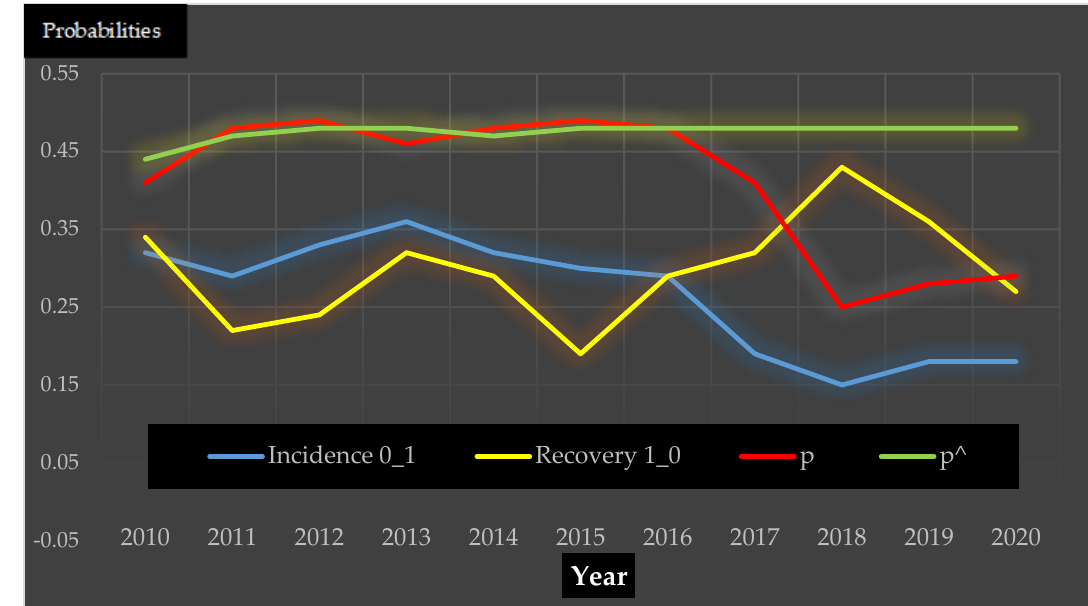
Figure 3. A comparative longitudinal line graph from 2009 to 2020 on four variables represented by the 4 coloured lines. 1. Red line - observed herd surveillance in pigs. 2. Green line - discrete-time Markov chain of predicted prevalence with 2009 herd prevalence as the first vector state (Tables 1 and 2) and probability transition matrix based on incidence rate and recovery rate for the first two years of 2009 and 2010 (Table 2). 3. Blue line - herd incidence rate. 4. Yellow line - herd recovery rate. The latter two longitudinal measurements were possible with pig herds tested contiguously for two consecutive years.